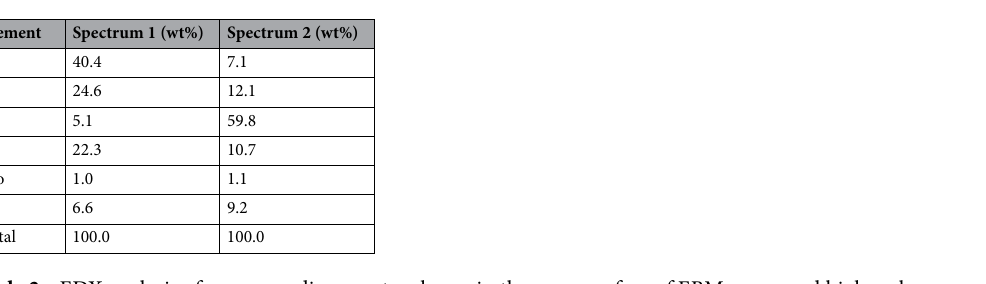
Table 2. EDX analysis of corresponding spectra shown in the worn surface of EBM-processed high carbon martensitic stainless steel at 3 N.